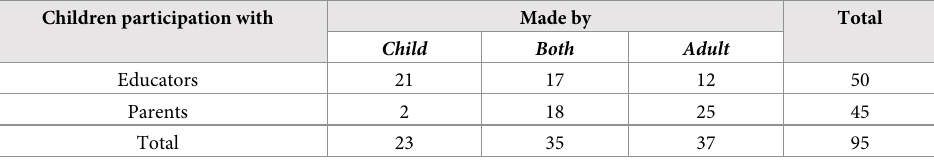
Table 3. Distribution of children participation with their parents and with their educators.